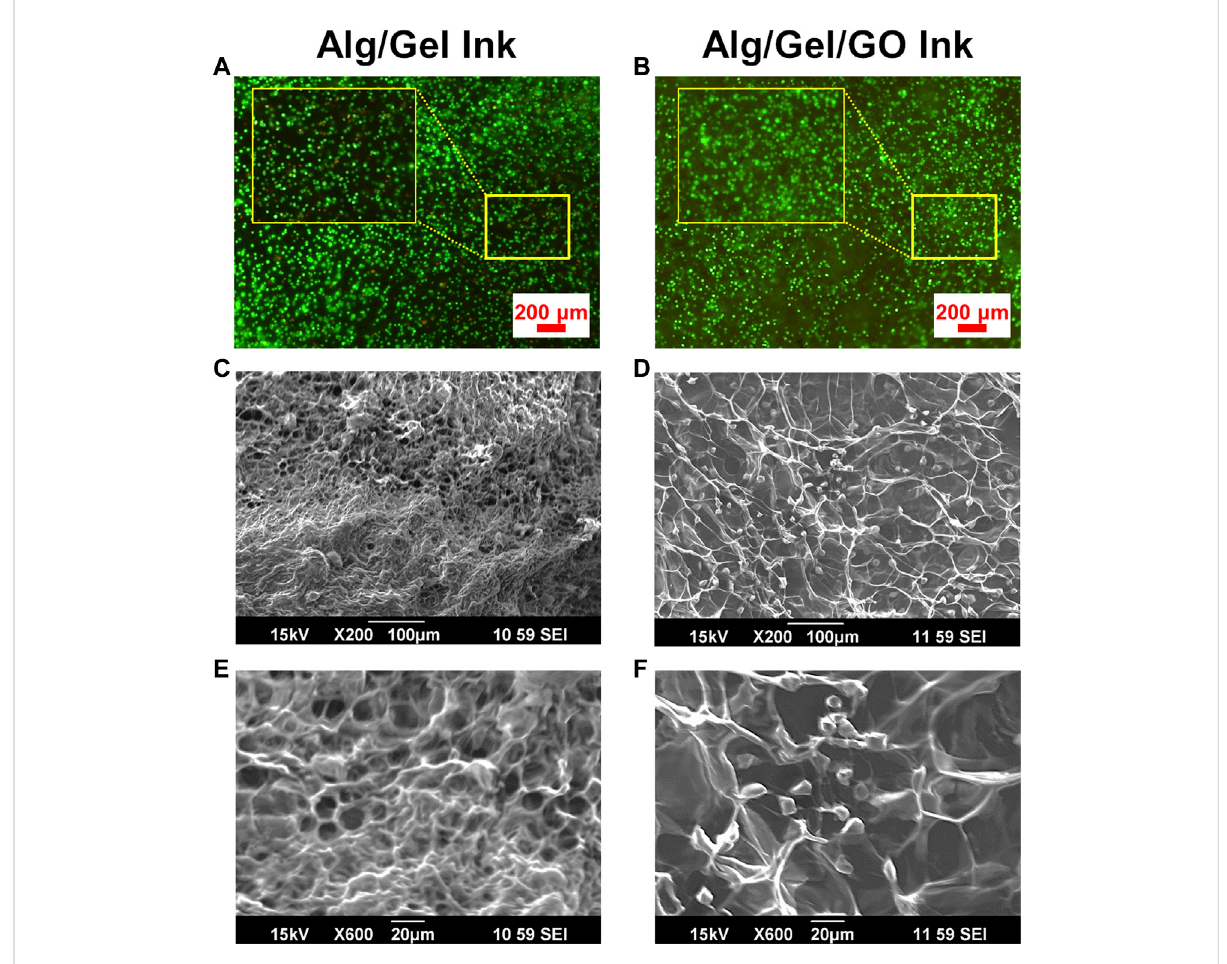
FIGURE 5 Improved ADSC viability in GO-containing inks. Fluorescence images of live (Calcein AM; green) and dead (PI; red) cell staining for ADSC-laden (A) pristine 2%/3% (w/w) Alg/Gel and (B) 2%/3%/0.05% (w/w) Alg/Gel/GO inks following culture for 1 day. SEM images of ADSC-laden (C,E) pristine 2%/3% (w/w) Alg/Gel and (D,F) 2%/3%/0.05% (w/w) Alg/Gel/GO inks at different magni fi cations following culture for 1